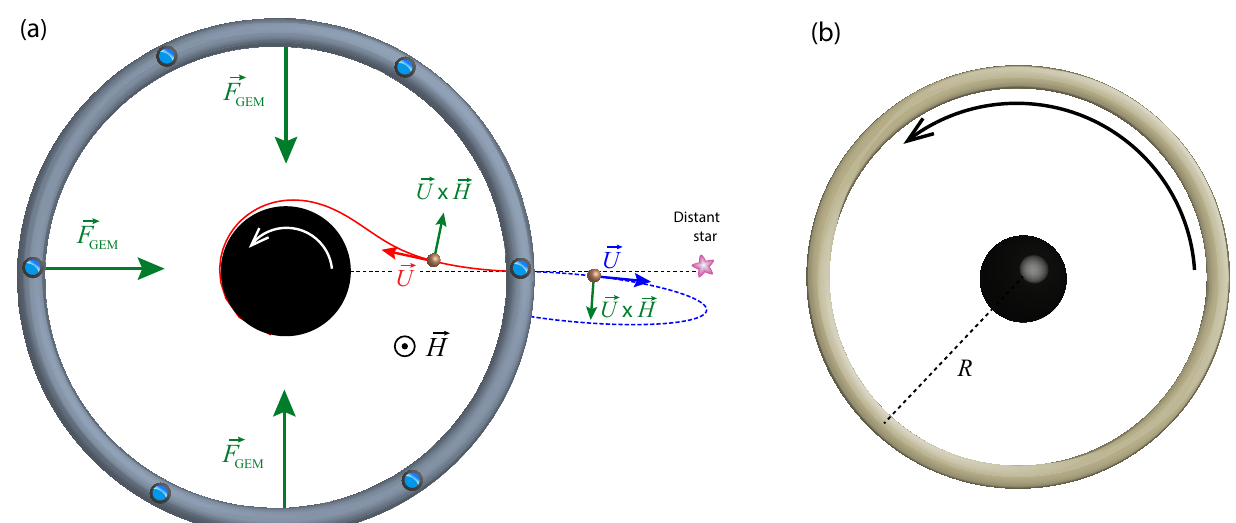
Figure 2. ( a ) A space station (radius R = 5 M ) around a spinning Kerr black hole ( a = 0.9 M ). It is not “dragged” around: if initially static, it remains so, each hatch pointing to the same distant star. The dragging of the compass of inertia does not affect it: the gravitomagnetic (i.e., Coriolis) forces vanish, the gravitational forces (9) exerted on the station reducing to gravitoelectric (i.e., “Newtonian”) forces, (cid:126) F GEM / m = γ 2 (cid:126) G , which are radial. It is affected only by the dragging of the ZAMOs, causing it to have a non-zero angular momentum, manifesting e.g., in a Sagnac effect along optical fiber loops around the station. A particle dropped from rest is deflected, along its infall, in the direction of the BH’s rotation, by the gravitomagnetic force m γ (cid:126) U × (cid:126) H ; however, a particle launched with initial outwards radial velocity ( v = 0.3 for the blue dashed trajectory) is deflected in the opposite direction, contradicting again the naive body-dragging picture. [Red and blue dashed trajectories are plots in Boyer–Lindquist coordinates obtained by numerically solving the geodesic equation]. ( b ) A rotating ring around a ‘non-spinning’ BH. The BH does not acquire any angular acceleration, and the configuration remains stationary. The consequence of the ring’s rotation is (via the dragging of the ZAMOs) causing a zero angular momentum BH ( J = 0 ) ; to have non-zero horizon angular velocity ( Ω BH (cid:54) = 0) and, conversely, a BH with zero angular velocity to have non-zero angular